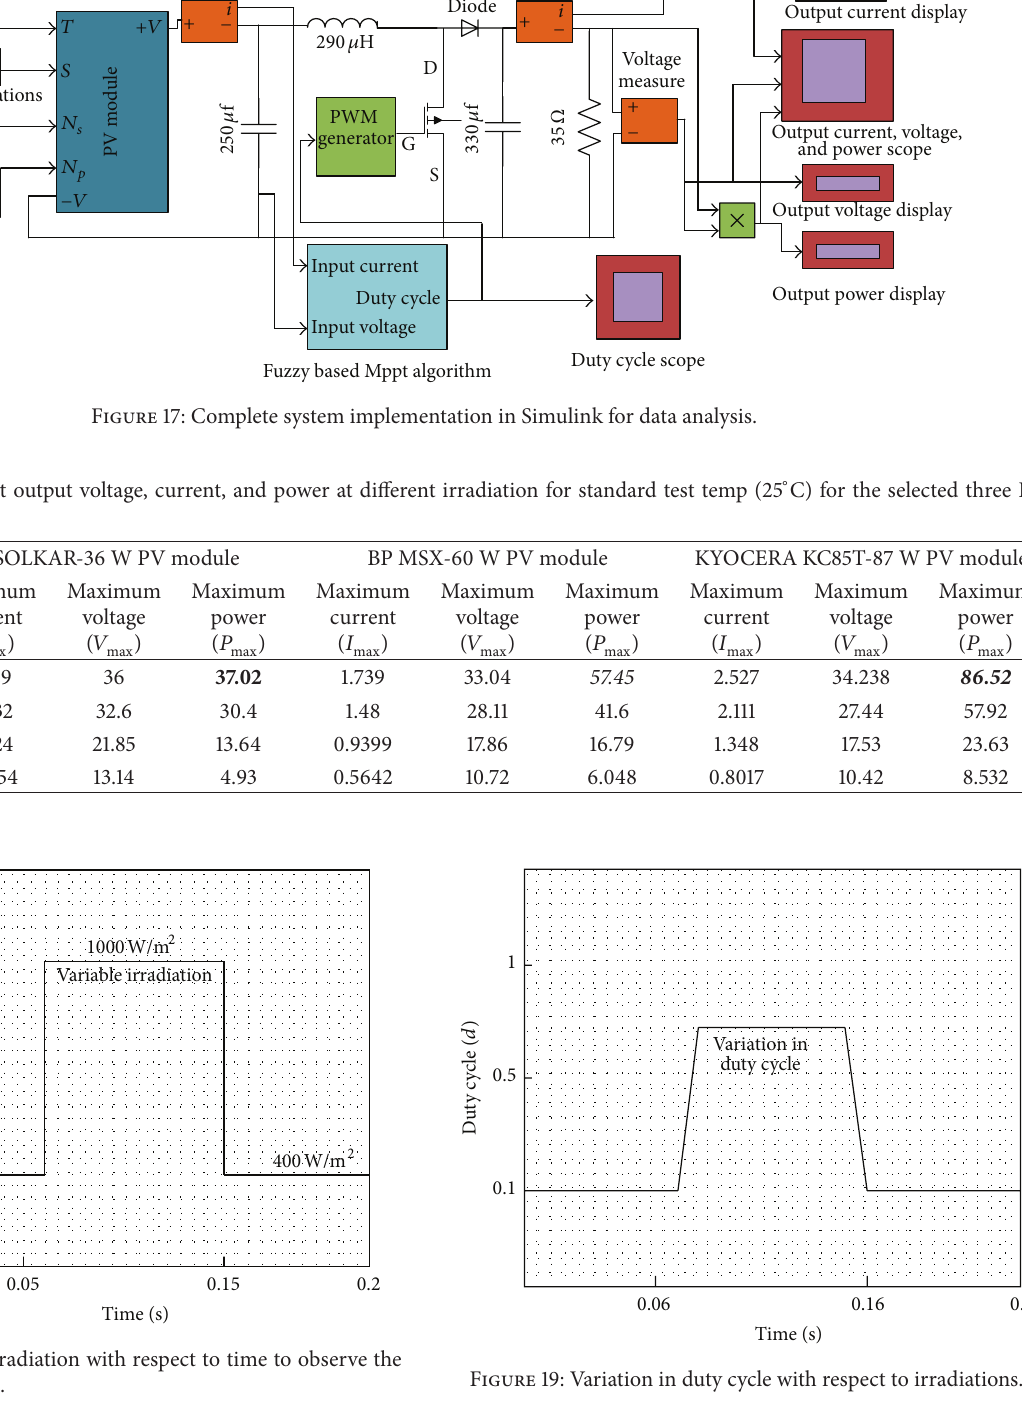
power tracking curves for the three PV modules. In Figure 21 for SOLKAR 36 W it has been shown that, at 𝑡 = 0.06 s, irradiation 𝑆 = 500 W/m 2 , and obtained power 𝑃 = 13 W, then irradiation goes from 𝑆 = 500 W/m 2 to 𝑆 = 1000 W/m 2 and it continues until 𝑡 = 0.15 s; from the tracking curve it is shown that power for this period is 𝑃 = 36 W; again at 𝑡 = 0.15